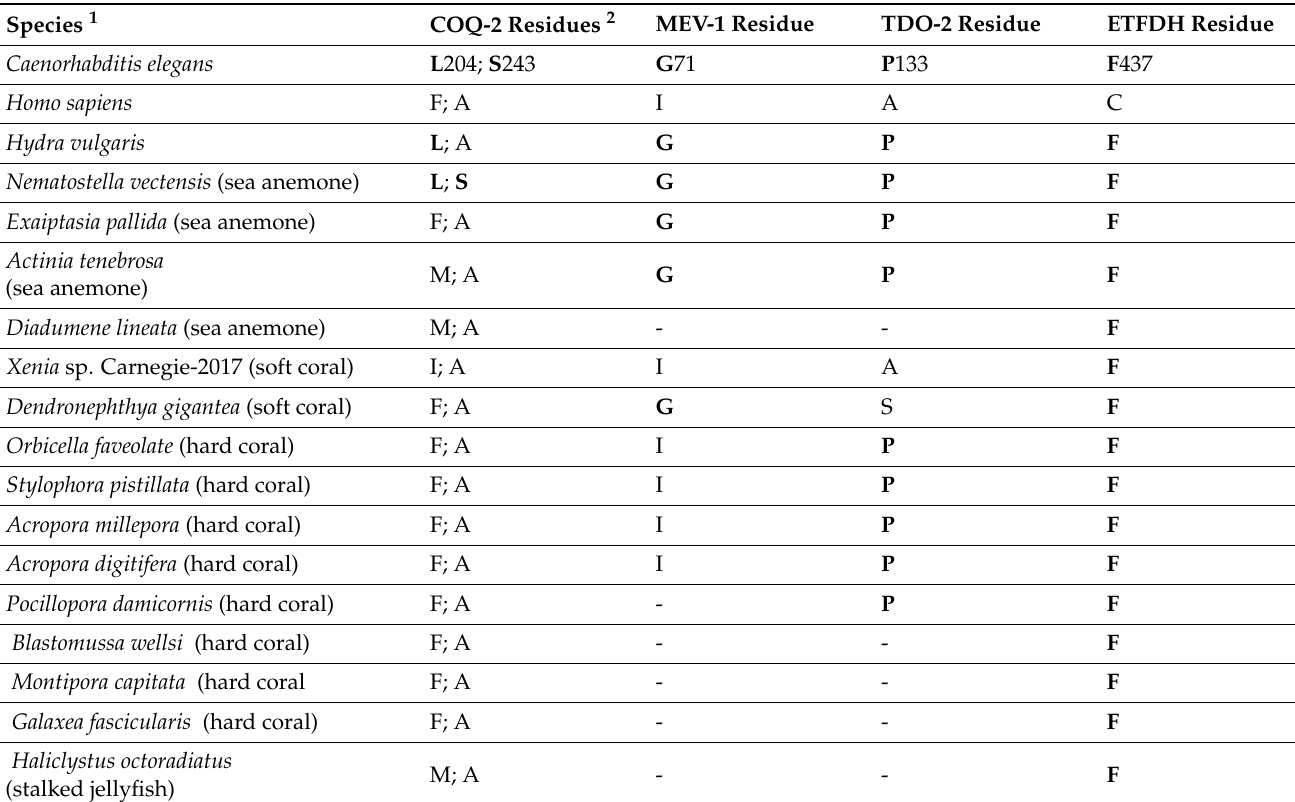
Table 1. Proteins and their specific residues to RQ-based anaerobic metabolism for the available genetic data of